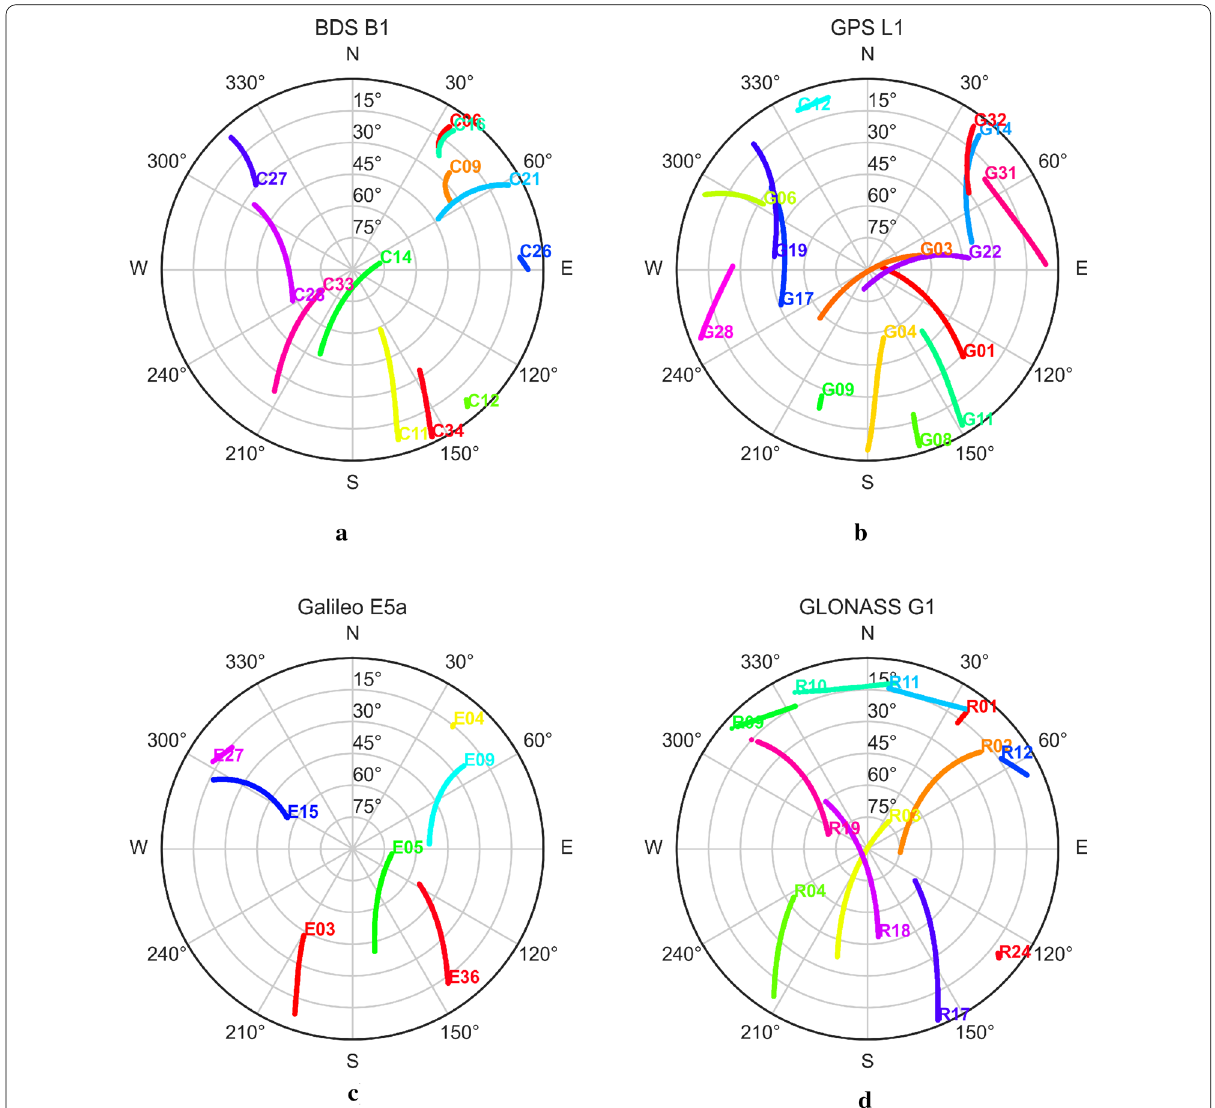
Fig. 7 Sky plots of the observed satellites on a BDS B1, b GPS L1, c Galileo E5a and d GLONASS G1 for two